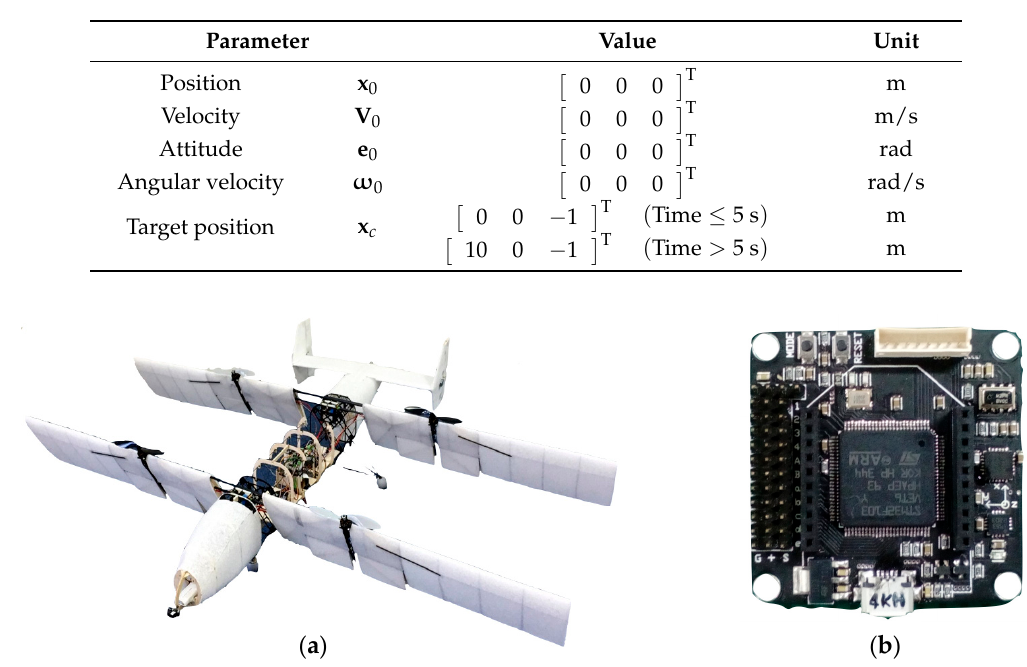
Figure 15. Developed ( a ) QTW-UAV and ( b ) avionics.